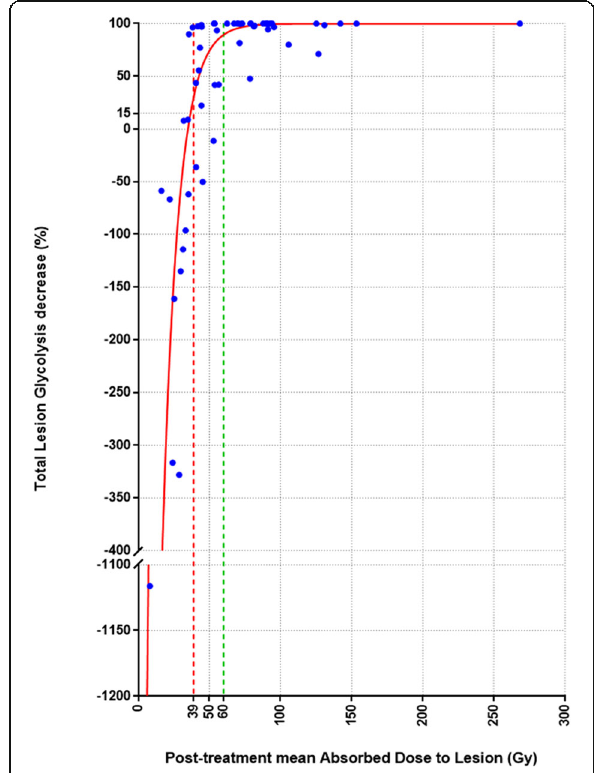
Fig. 4 Regression analysis between post-treatment mean absorbed dose and the metabolic response assessed by TLG-decrease on a lesion by lesion basis ( R 2 = 0.82). Red and green lines represents post-treatment mean absorbed dose cutoff values for predicting respectively non-mR (39 Gy) and high-mR (60 Gy)